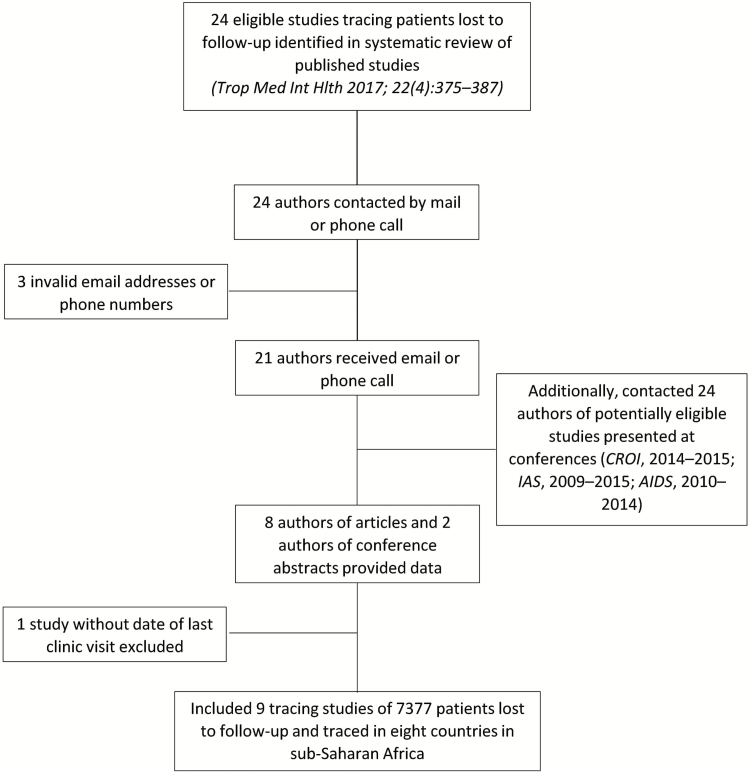
Flow of identifying eligible studies that contributed individual patient data.